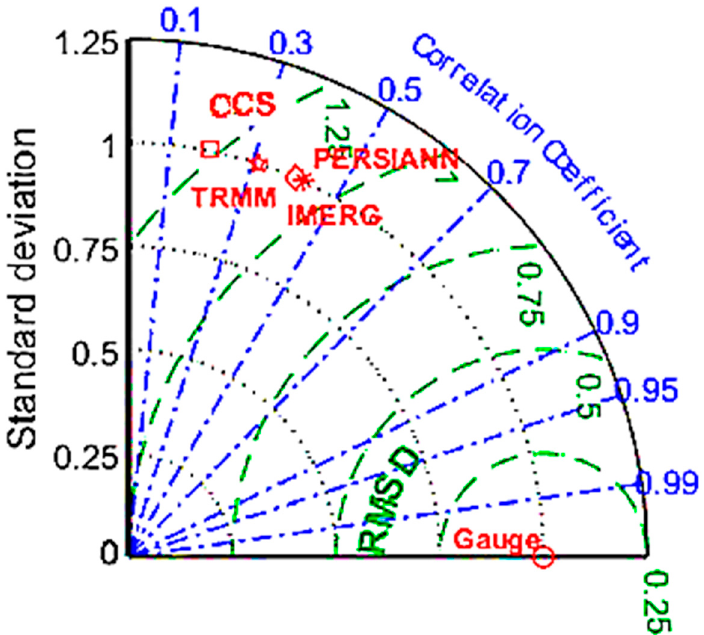
Figure 11. Taylor diagram showing the performance of daily estimation of SBPD.